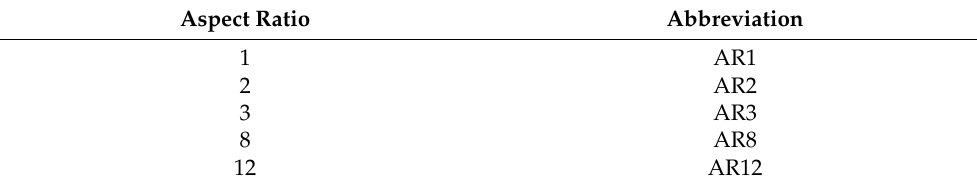
Table 1. Computational fluid dynamics (CFD) case